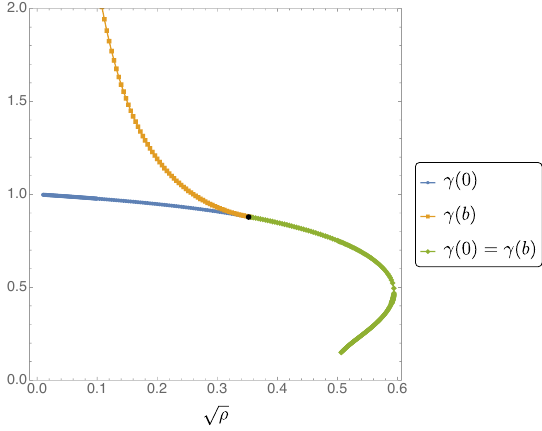
Figure 16 . The resdhift (cid:13) (0) of the central geodesic and the maximum gravitational potential p along the axis (cid:13) ( b ) as a function of (cid:26) . These quantities are plotted respectively in blue and orange when they do not coincide. But beyond a certain threshold (black dot) the maximum occurs at the origin and (cid:13) ( b ) = (cid:13) (0). In this regime (green) the central geodesic is unstable. Note that it p includes the region near (cid:26) turn (cid:25) 0 :